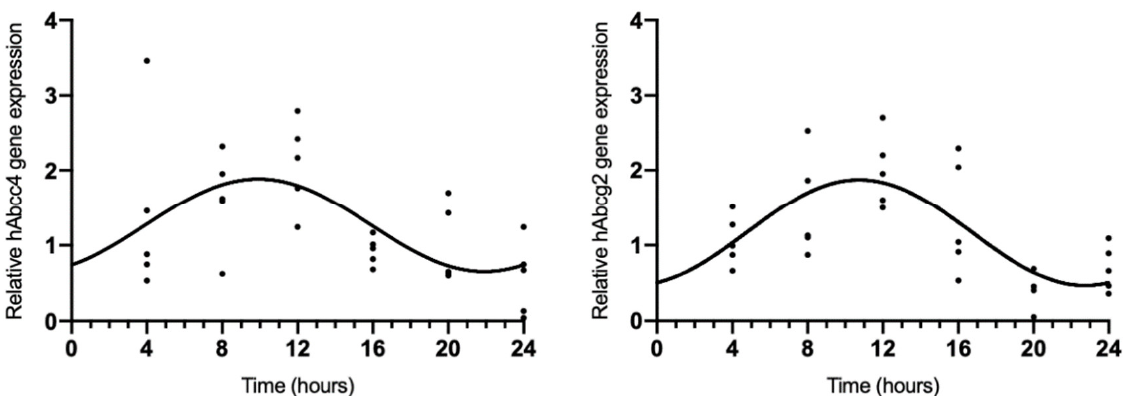
Figure 2. CircWave analysis of membrane transporters rAbcc1, rAbcc4, rAbcg2, and rOat3 mRNA circadian expression in the CPs of intact male and female rats. Absence of the CircWave curve indi- cates absence of significant rhythmicity as analyzed by CircWave. White and grey backgrounds represent the day and night periods, respectively.